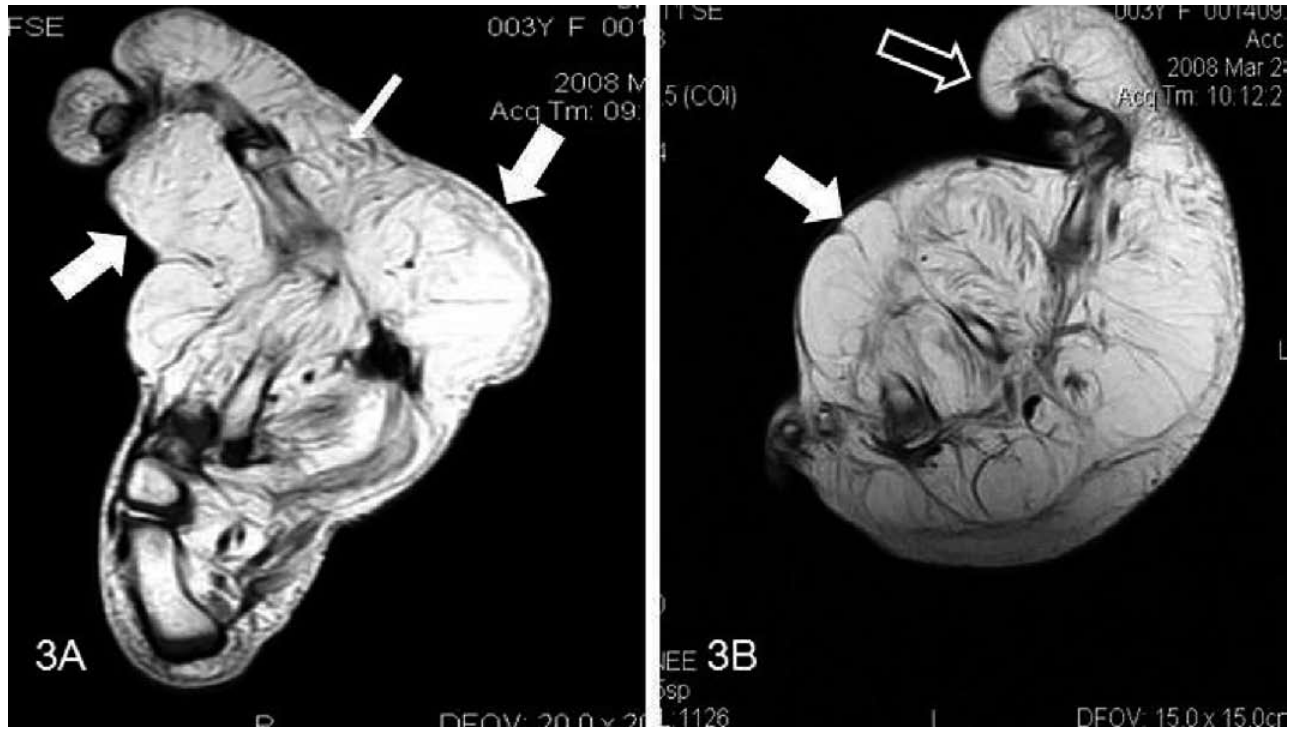
Fig. 3A. T1W sagittal images of the right foot showing local gigantism owing to gross hypertrophy of fat (thick white arrows) and soft tissue in a striated pattern ( thin white arrow).